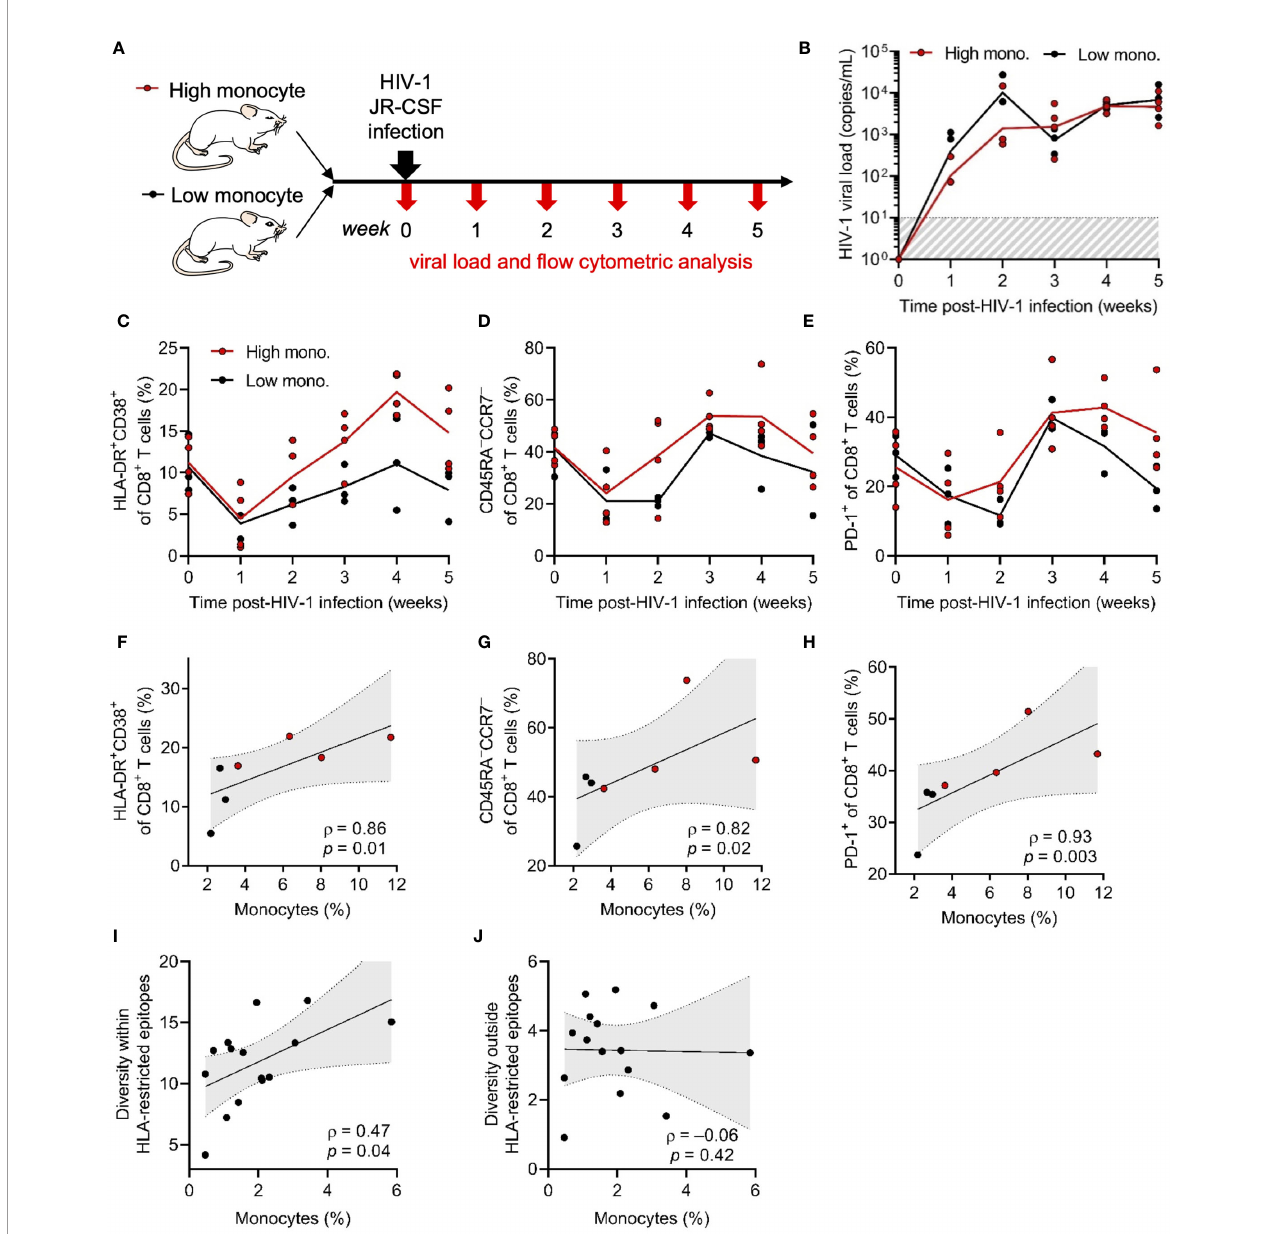
FIGURE 6 | CD8 + T cell responses to HIV-1 infection correlate with innate immune reconstitution. (A) Represented is a schematic of HuBLT mice ( n = 7 mice from 1 human donor tissue) grouped into a high peripheral blood monocyte frequency group (high mono.; red circles) and a low monocyte frequency group (low mono.; black circles). Mice were infected with HIV-1 JR-CSF (2 x 10 5 TCID 50 , intraperitoneal route) and CD8 + T-cell phenotypes were longitudinally assessed via fl ow cytometry. (B) HIV-1 viremia was assessed longitudinally by qRT-PCR speci fi c for gag p24 in each HuBLT mouse; lines represent group means over time. (C – E) CD8 + T cell activation (HLA-DR + CD38 + ; in C ), differentiation into effector memory cells (CD45RA – CCR7 – ; in D ), and expression of the activation/exhaustion marker PD-1 (in E ) was assessed at different times post infection; lines represent group means over time. (F – H) Monocyte reconstitution (percent of CD14 + cells of all hCD45 + cells) was correlated to peak CD8 + T-cell responses (week 4). (I, J) In a separate experiment, HuBLT mice ( n = 15 mice from 1 human donor tissue) were infected with